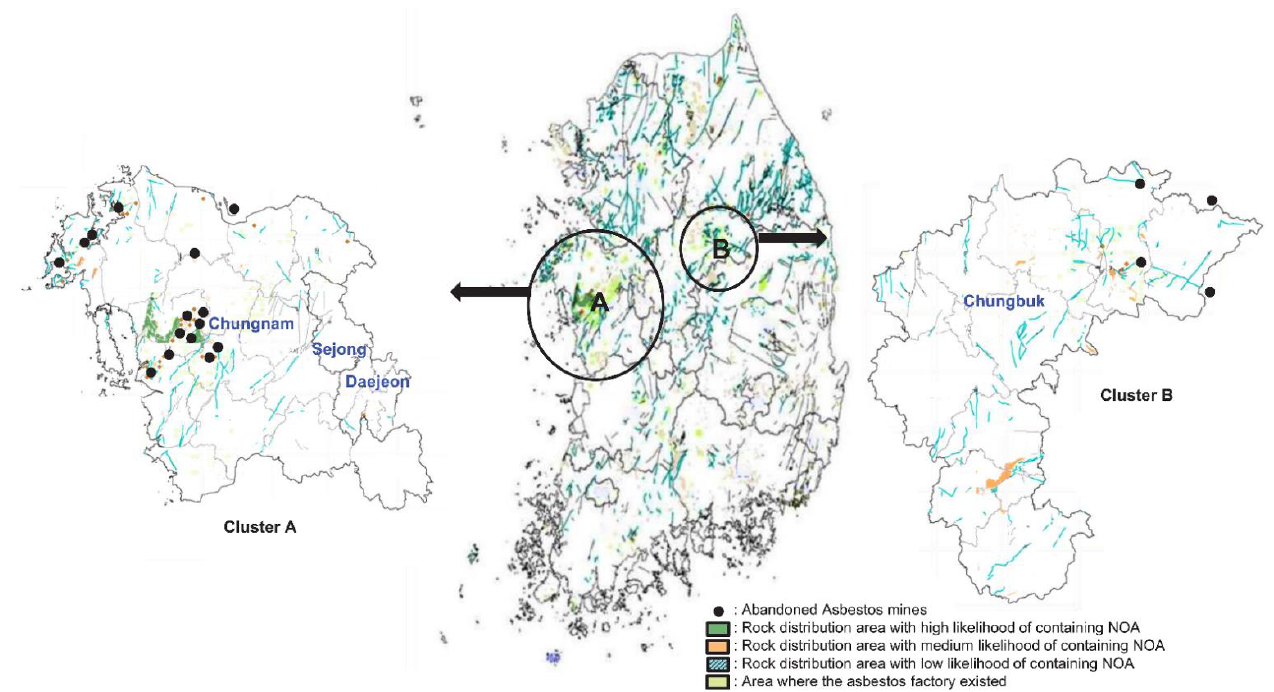
Figure 2. Location map of abandoned asbestos mines included in the pooled analysis in South Korea. (Map source: Asbestos Management Comprehensive Information Network; https://asbestos.me.go.kr, accessed on 22 April 2021).